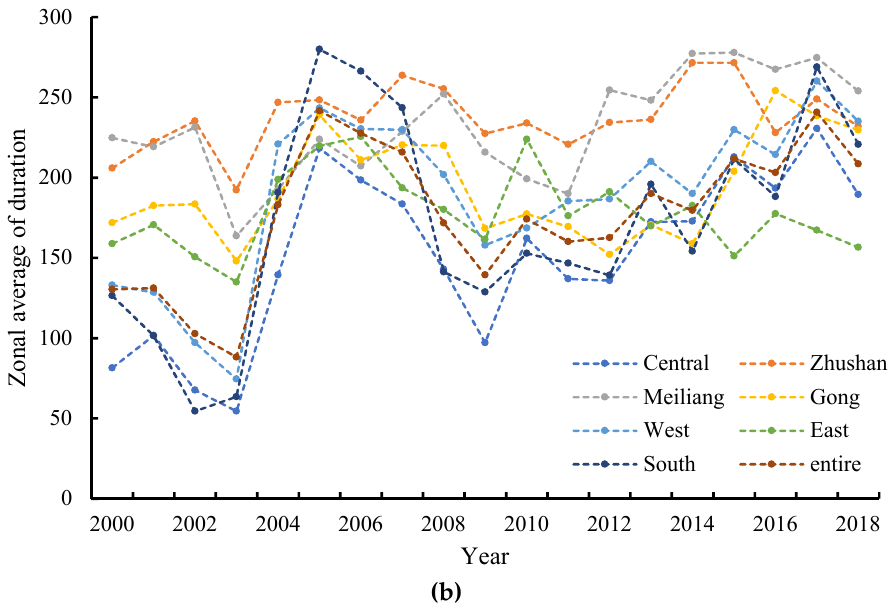
Figure 13. ( a ) Spatial distributions of the annual duration of cyanobacteria blooms; ( b ) zonal average statistics of the annual bloom duration.